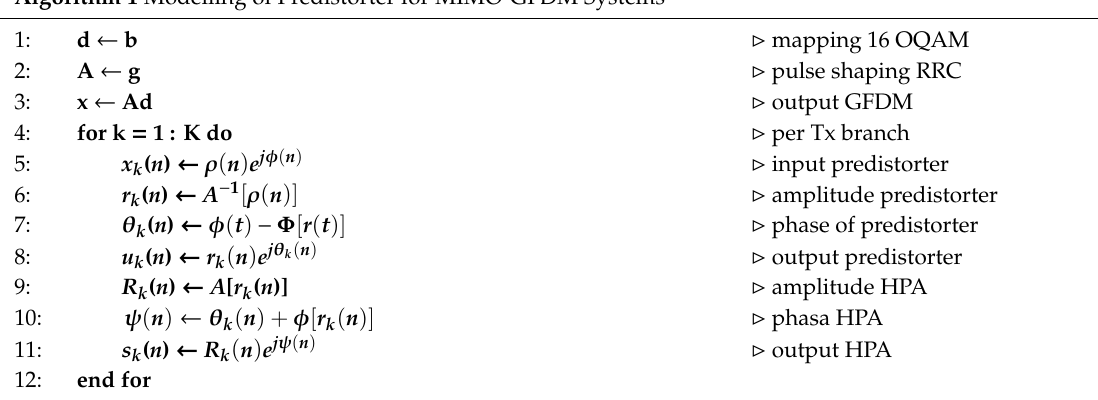
Algorithm 1 Modelling of Predistorter for MIMO-GFDM